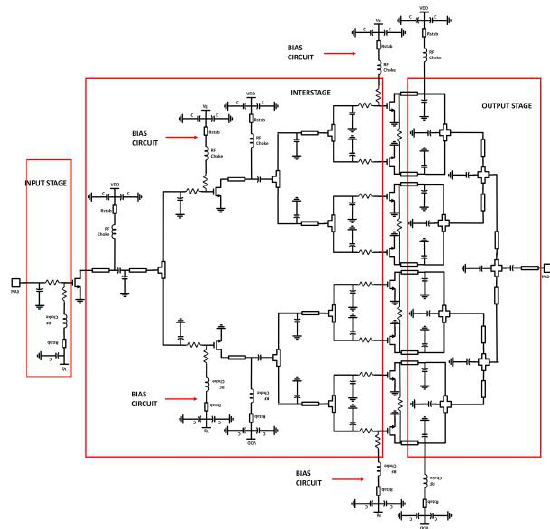
Figure 3: Schematic for 3 stage 8-10 GHz PA design